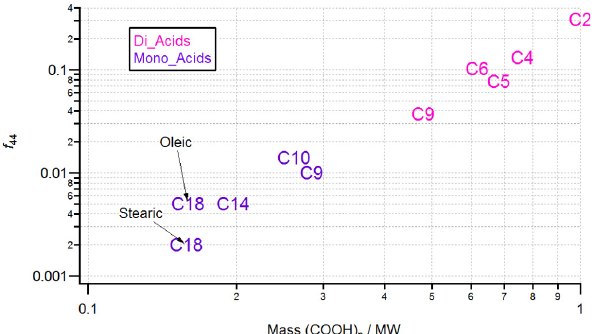
Fig. 8. The fractional contribution of m/z 44 ( f 44 ) for mono- and di-carboxylic acids versus the ratio of the mass of carboxylic acid groups to the molecular mass of the individual acids. This figure normalizes the mass of the acid groups to the molecular weight and compares it to f 44 in the mass spectrum for each acid. It shows a tendency for di-acids to produce more m/z 44 per COOH group than